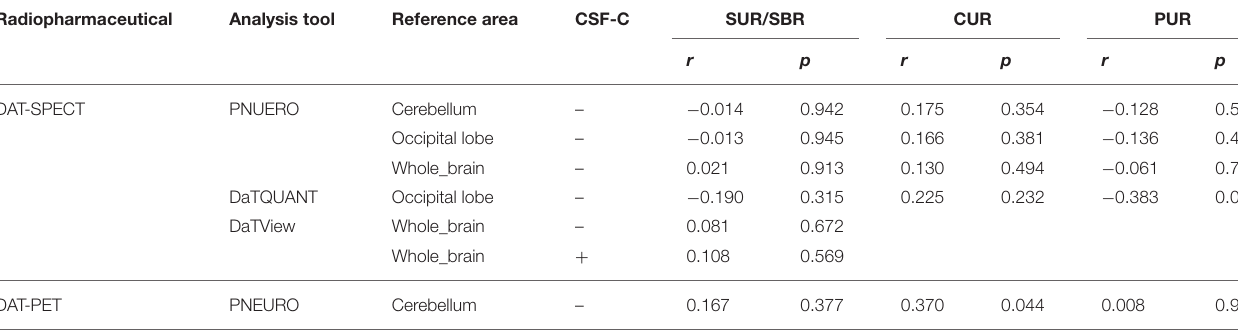
TABLE 4D | Correlation between Volume and the SUR/SBR, CUR, and PUR of DAT-SPECT and DAT-PET.